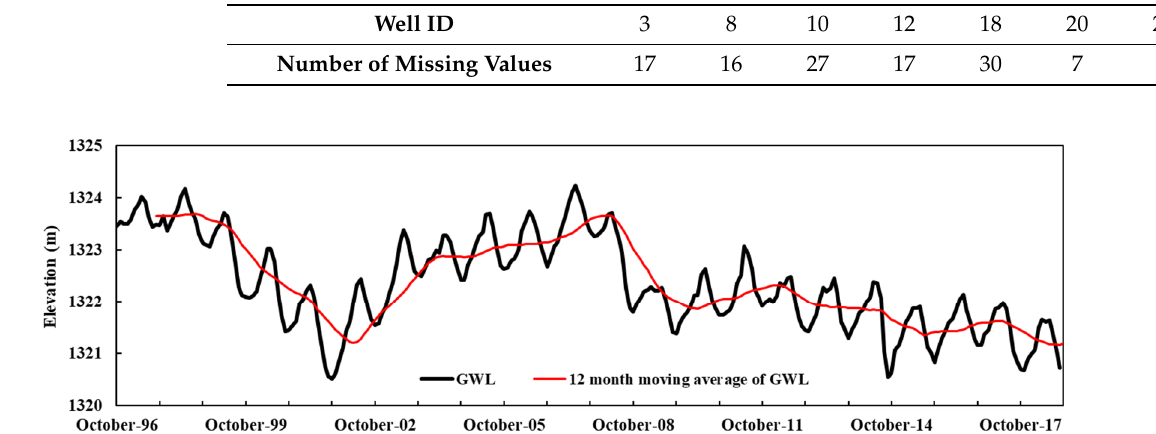
Figure 3. Average groundwater level (GWL) fluctuations in the Maragheh plain during 1996–2018.